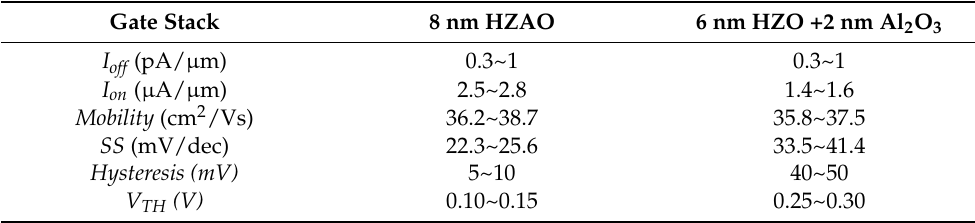
Table 2. Electrical parameters of the HZAO NCFETs and HZO-Al 2 O 3 NCFETs.